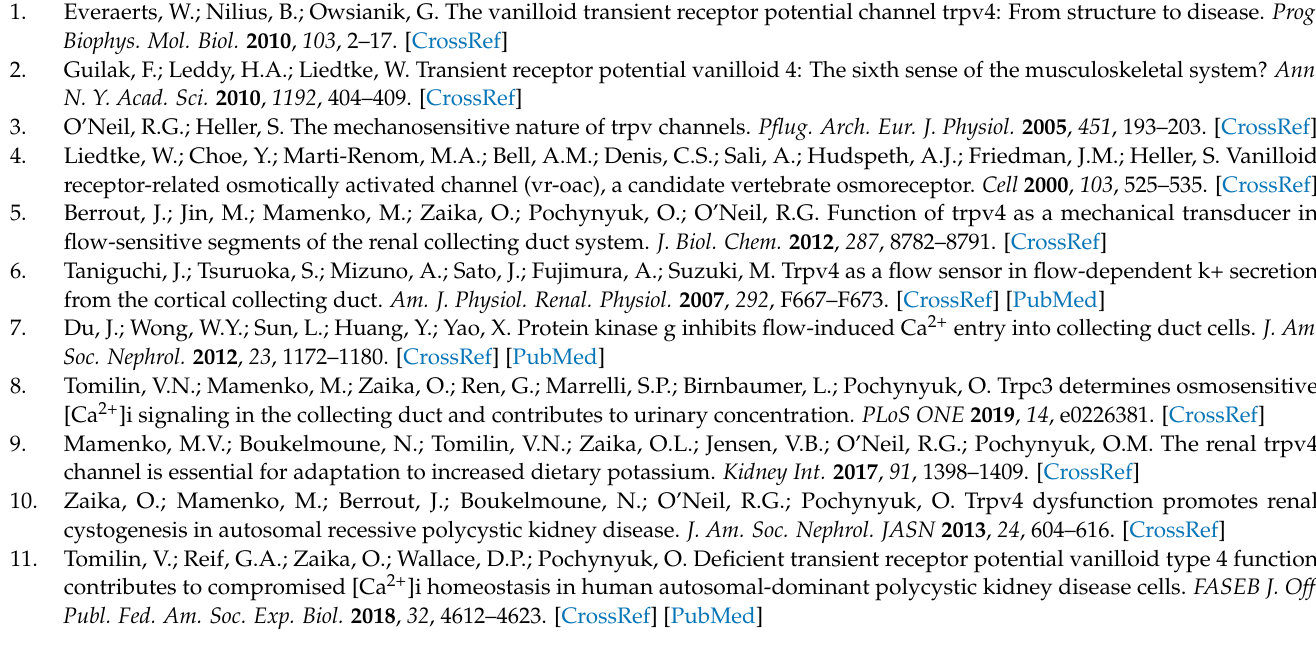
antibodies. Figure S3: Cortisone increases TRPV4-dependent Ca 2+ influx in mpkCCD c14 cells. Figure S4: Verification of monitoring TRPV4-dependent current in CHO